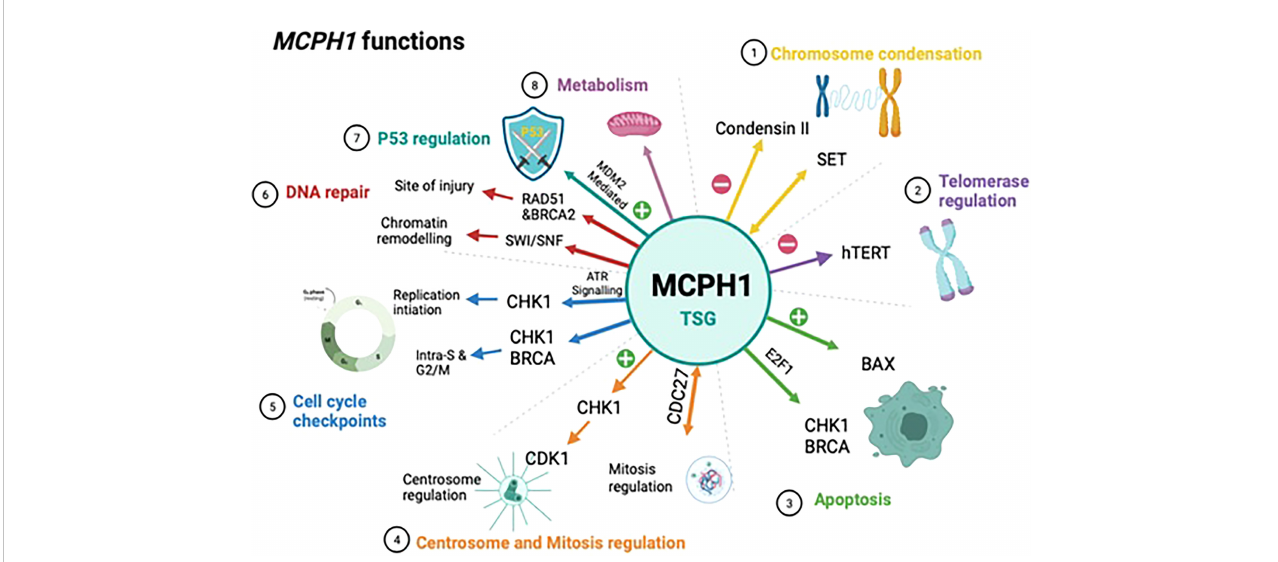
FIGURE 2 Schematic showing the biological functions of MCPH1/BRIT1. This schematic summarises the biological functions of MCPH1/BRIT1 which supports to its role as a tumour suppressor. 1) MCPH1/BRIT1 affects chromosomal condensation by inhibiting condensin II when it interacts with both non-SMC condensin II complex subunit D3 (NCAPD3) and non-SMC condensin II Complex Subunit G2 (NCAPG2) causing an abnormality in spindle structure and chromosome misalignment. 2) The telomere binding protein (TRF2) interacts with the MCPH1/BRIT1 protein forming the MCPH1/BRIT1 – TRF2 complex which increases DNA damage factors localisation, resulting in repair of defective telomeres and increasing telomere replication. 3) MCPH1/BRIT1 promotes cell apoptosis and cell cycle arrest in the S and G2/M phases and overexpression of MCPH1/BRIT1 inhibits uncontrolled cell proliferation. 4) MCPH1/BRIT1 de fi cient cells demonstrate early mitotic entry which results in spindle organization abnormalities and chromosomal misalignment. 5) MCPH1/BRIT1 regulates the intra-S and G2/M cell cycle checkpoints. MCPH1/BRIT1 is required for adaptive response to avoid topoisomerase II inhibition-mediated G2 arrest and proper chromosomal alignment during prometaphase. 6) Mutations in MCPH1/BRIT1 could lead to defects in DNA repair and cancer development, since MCPH1/BRIT1 is required to recruit and maintain the BRCA2-Rad51 complex at the site of DNA injury and regulate homologous recombination repair of DNA DSBs in a BRCA2-dependent manner. 7) High MCPH1/BRIT1 expression stabilizes p53 function by inhibiting MDM2 and may impact chemotherapy response. 8) MCPH1/BRIT1 is crucial for controlling mitochondrial activity and participating in bioenergetic pathways including oxidative phosphorylation pathways.